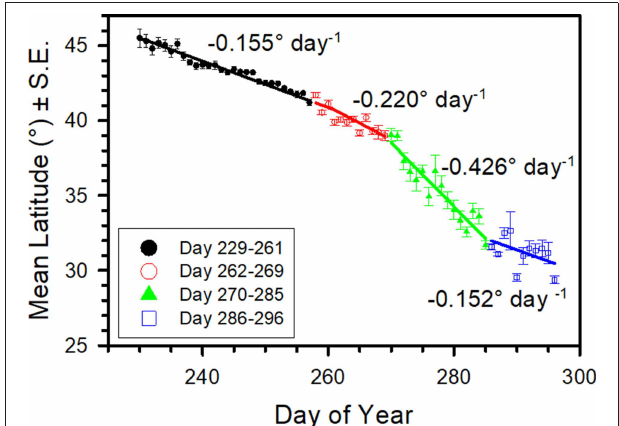
FIGURE 3 | Mean daily latitude ( ◦ ) ( ± S.E.) of tagging location vs. tagging day-of-year for wild-caught monarchs whose tags were eventually recovered in the Monarch Butterfly Biosphere Reserve (MBBR). Data are from 2004 to 2015 and between longitude 90–102 ◦ W. Line represents multivariate adaptive regression splines curve. Daily movement rates in ◦ latitude day − 1 are shown for each segment of the curve.